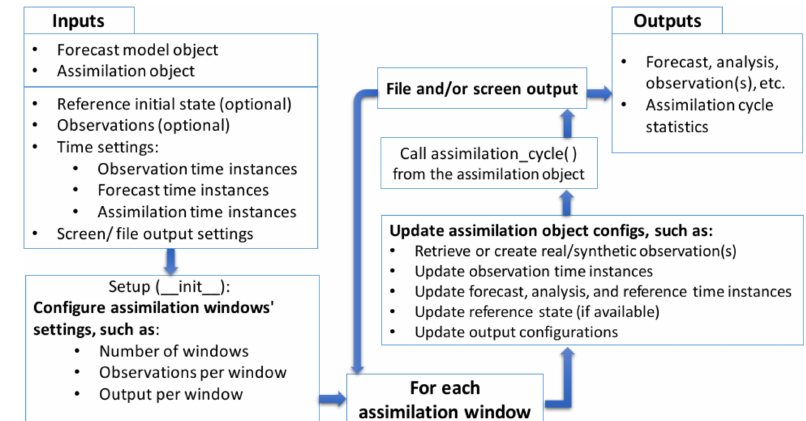
Figure 3. The assimilation process in